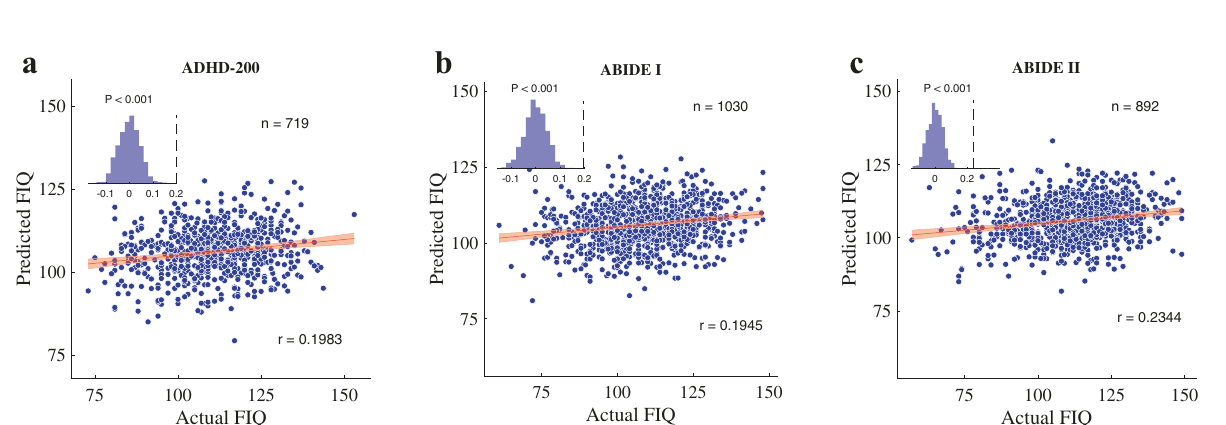
Fig. 5 Reproducibility of FSIQ prediction model on independent cohorts. The cross-validated uni fi ed model trained on HBN was applied to three independent cohorts with different distributions of demographics, age and IQ. a The ADHD-200 dataset ( n = 719). b The ABIDE I dataset ( n = 1030). c The ABIDE II dataset ( n = 892). Each inset displays the null distribution of model performance by permutation testing with 1000 permutations. Dashed line indicates actual performance. Error bar shows standard